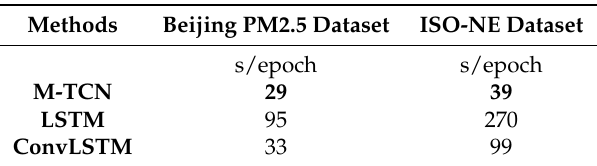
Table 5. Model training